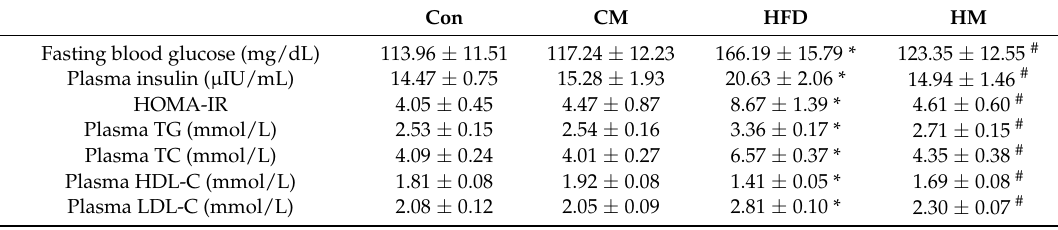
Table 1. Regressive effects of myricetin on blood glucose, plasma insulin and lipid profiles. Con CM HFD HM Fasting blood glucose